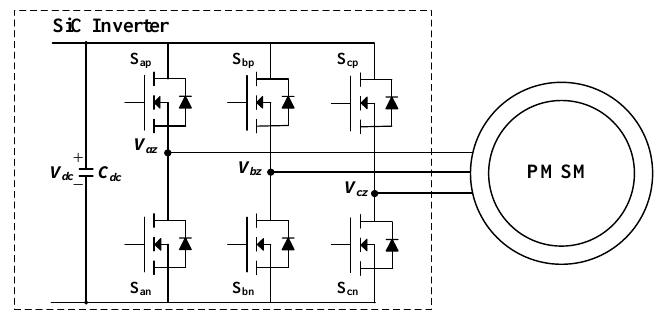
Figure 1. Railway propulsion system consisting the silicon carbide (SiC) inverter and permanent magnet synchronous motor (PMSM).